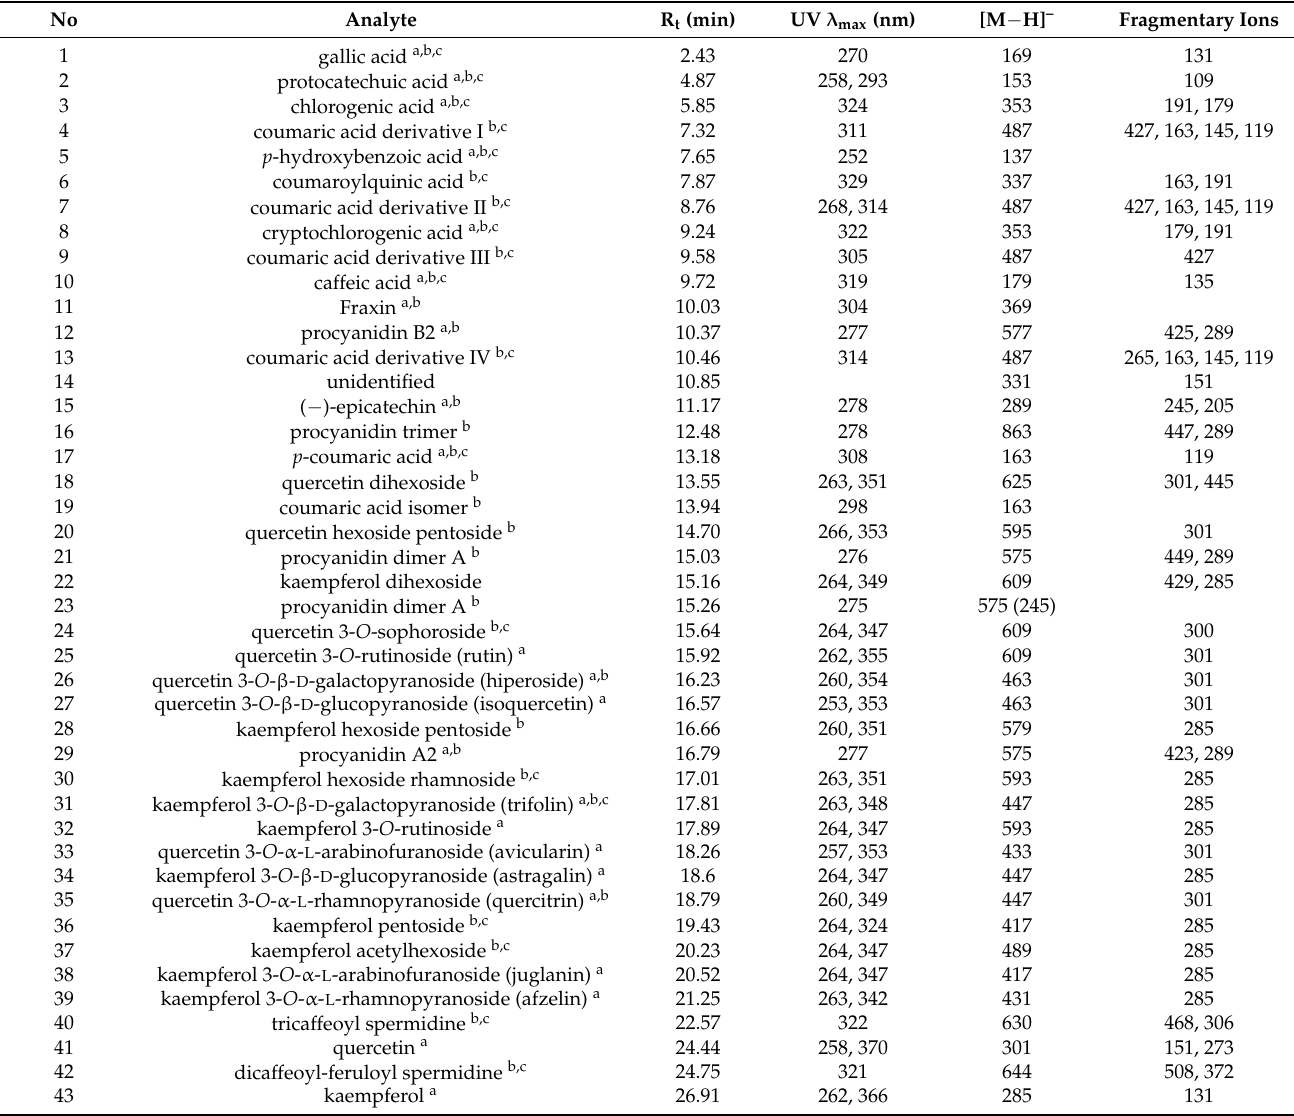
Table 1. UHPLC–PDA–ESI–MS/MS data of compounds detected in dry extracts from the flower of A. hippocastanum